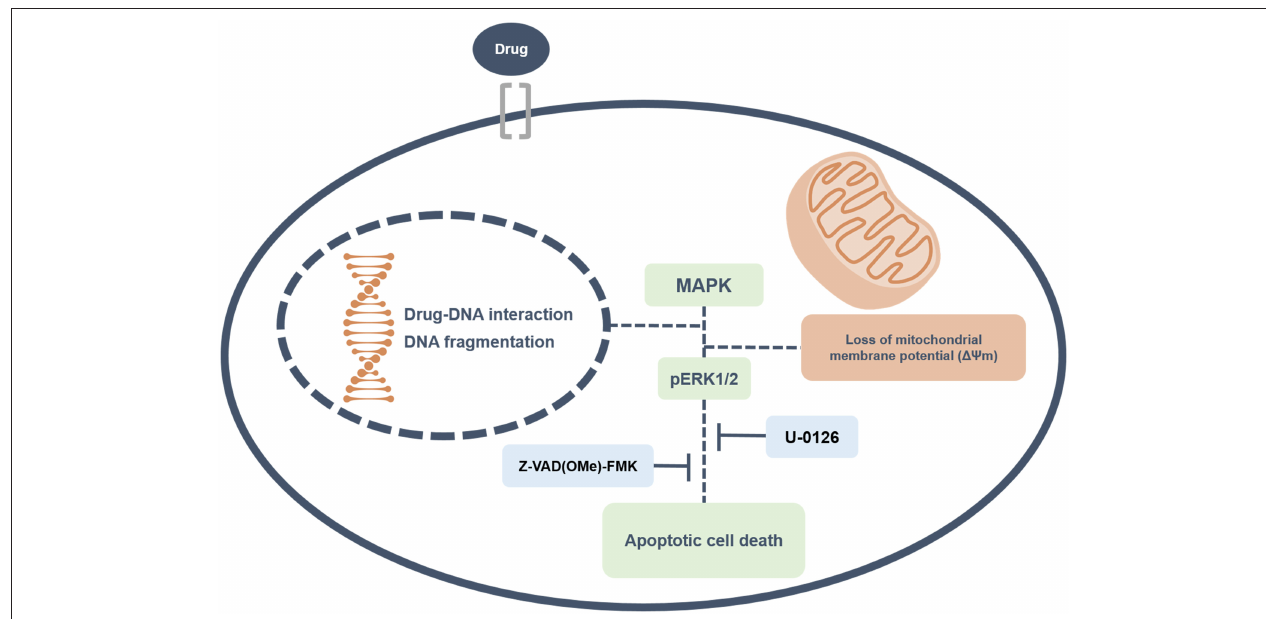
FIGURE 13 | Summary of the molecular mechanisms of ruthenium complexes containing heterocyclic thioamidates in HepG2 cells. Herein, we revealed that these complexes bind to DNA triggering caspase-mediated apoptosis through ERK1/2 signaling in HepG2